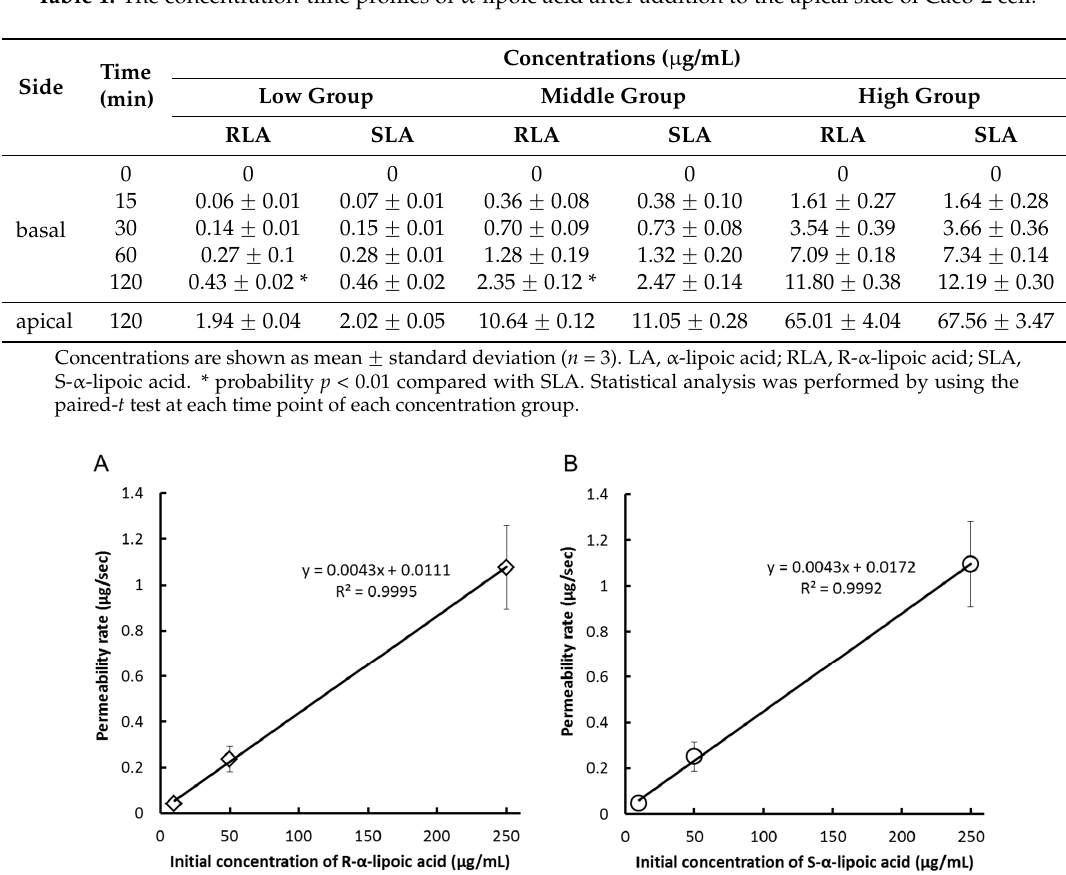
Table 1. The concentration-time profiles of α -lipoic acid after addition to the apical side of Caco-2 cell. Time Side Side